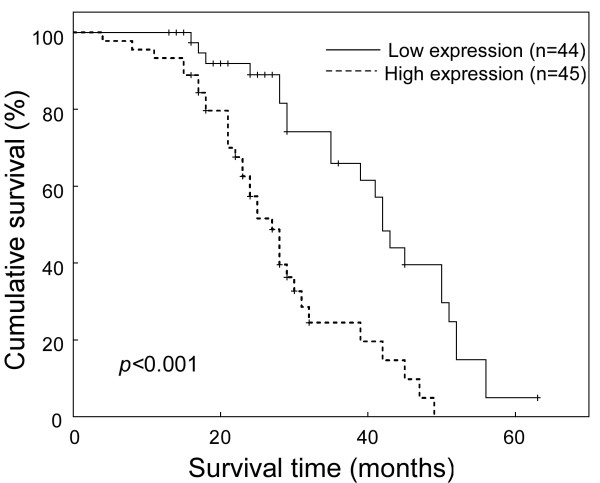
Kaplan-Meier curves with univariate analyses (log-rank) for patients with low SOX9-expressing (bold line) versus high SOX9-expressing tumors (dotted line). The cumulative 3-year survival rate was 65.9% in the low SOX9 expression group (n = 44), whereas it was only 24.5% in the high SOX9 expression group (n = 45).